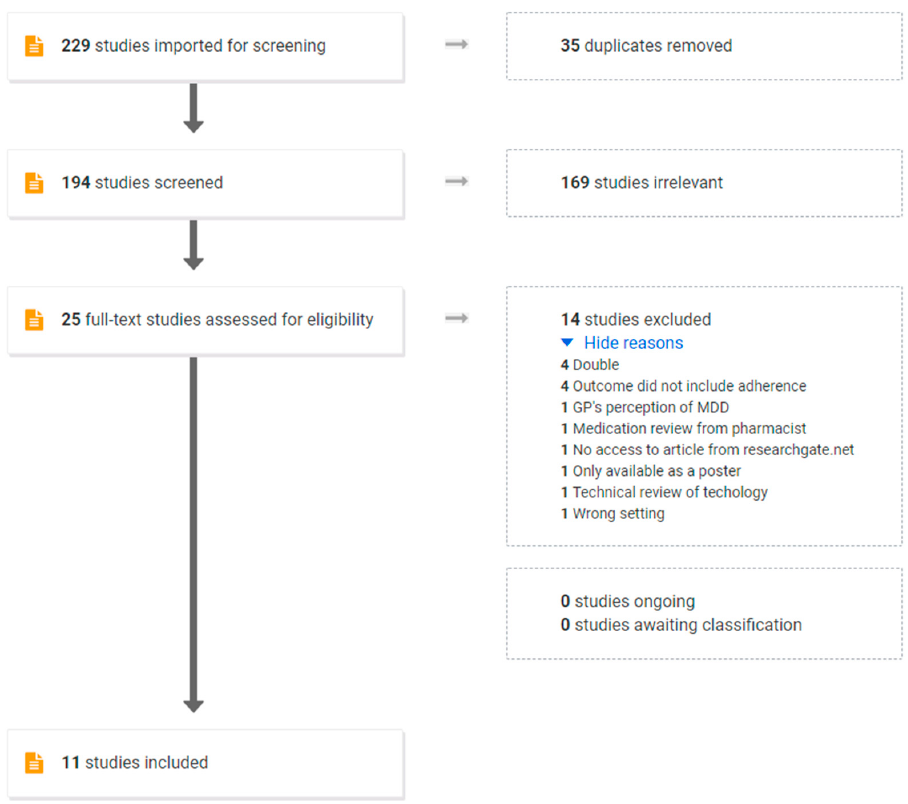
Figure 1. An overview of the literature retrieval process.